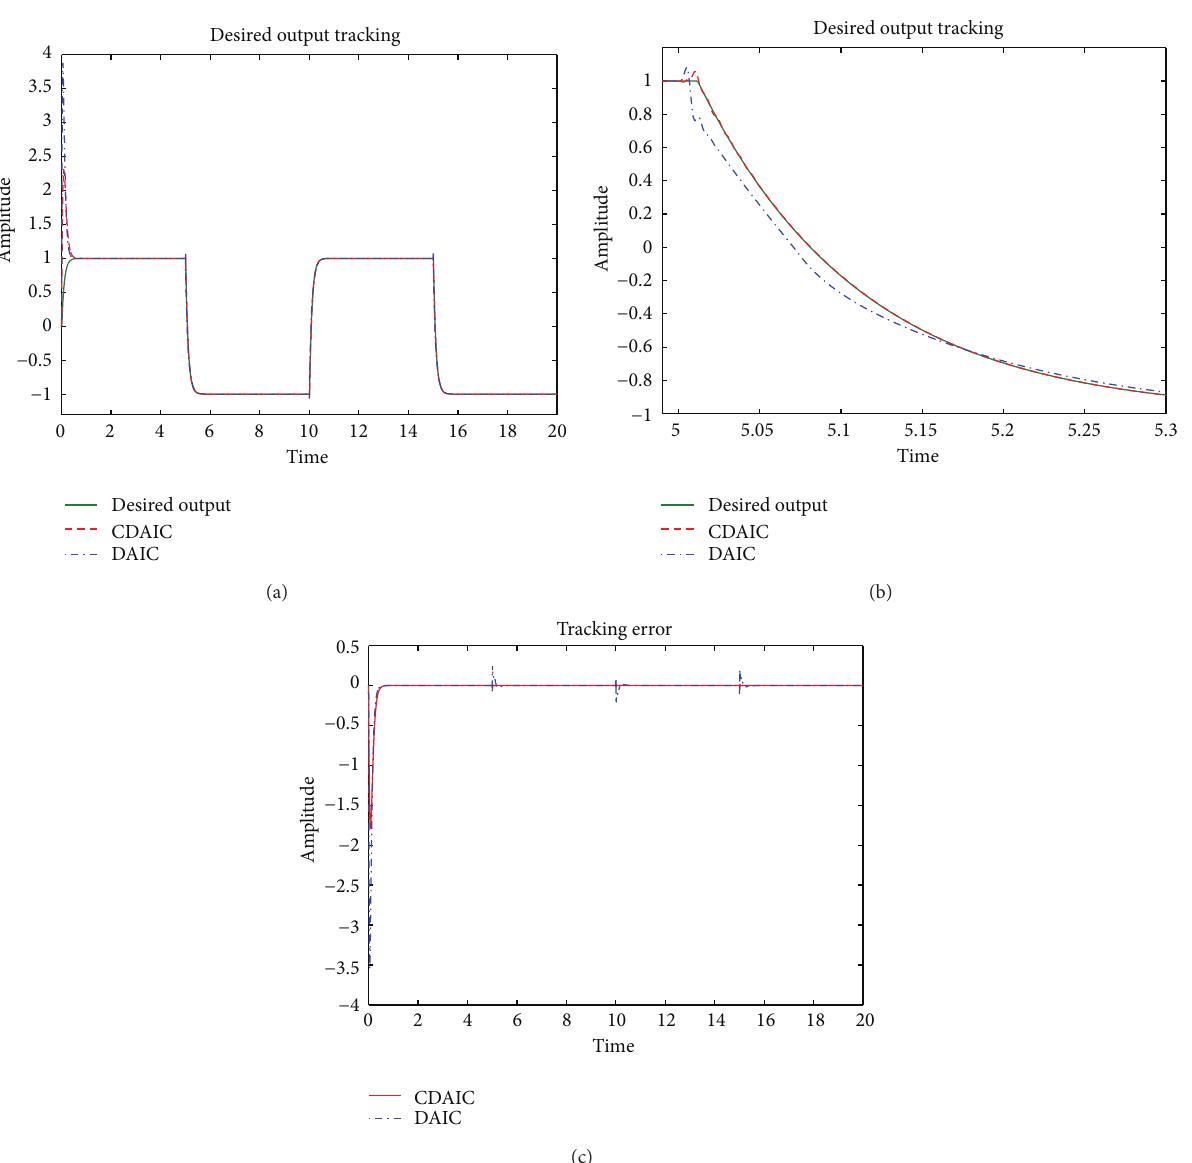
Figure 3: Example 1: simulation results: (a) tracking desired output; (b) tracking desired output (zoomed preview); (c) tracking